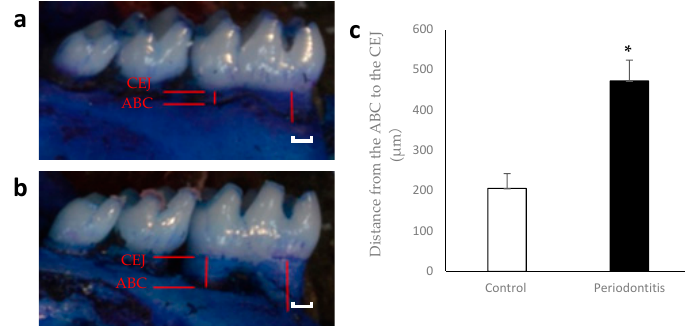
Figure 2. Alveolar bone loss at day 7. Representative photographs of mandibular bone in the control ( a ) and periodontitis ( b ) groups are shown. Red lines indicate the distance from the alveolar bone crest (ABC) to the cemento-enamel junction (CEJ). The distance was significantly higher in the periodontitis group than in the control group at day 7 ( c ) (* p < 0.05, t -test) ( n = 6/group). White scale bar = 200 µm.